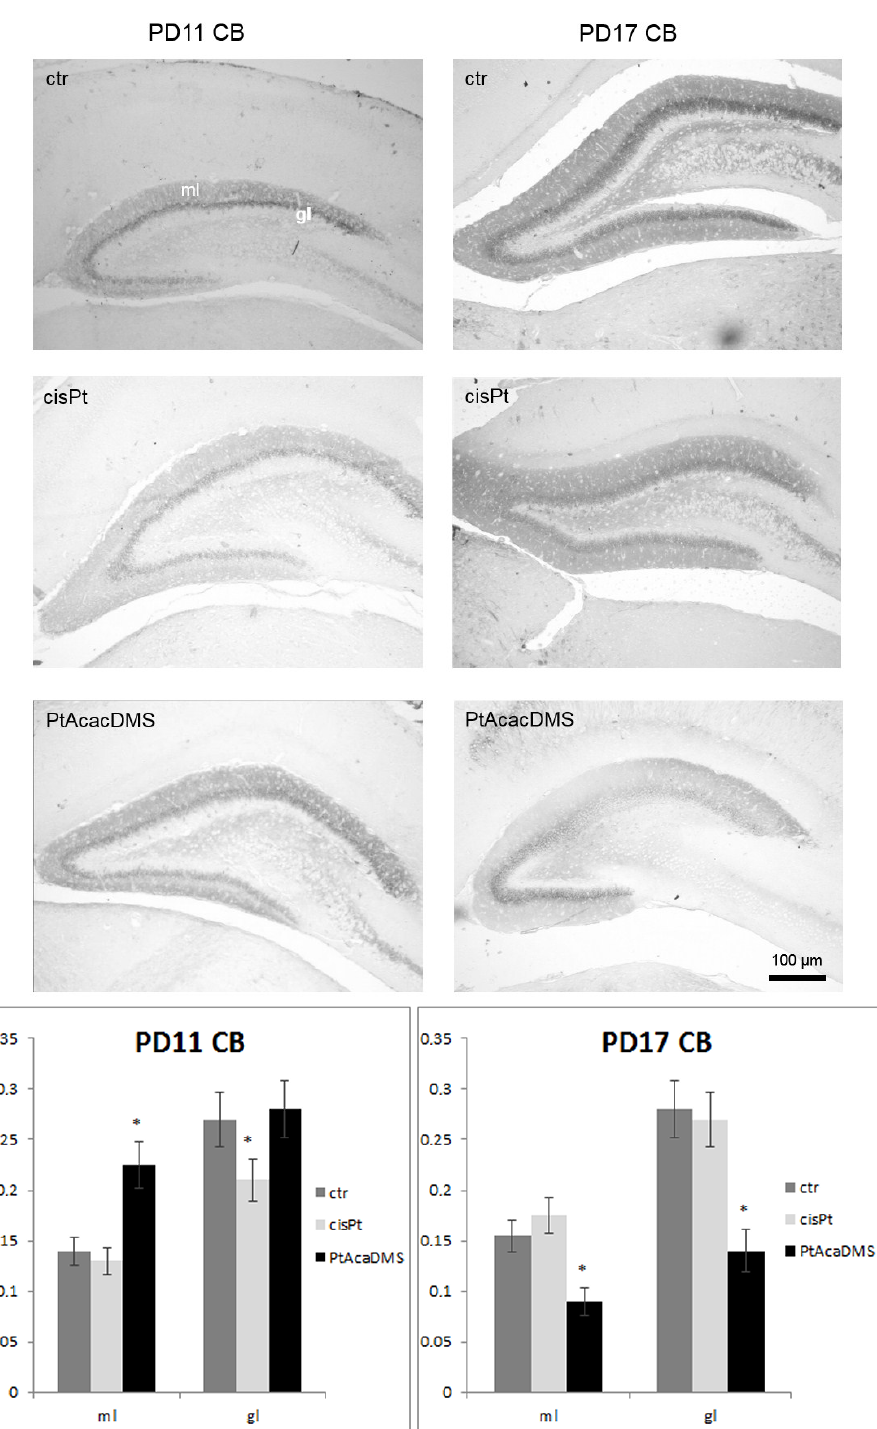
Figure 2. Calbindin immunocytochemistry in the DG granule cell layer . At PD11 , the intensity of labelling in the DG granule cells decreases after cisPt and increases after PtAcacDMS. At PD17 , decreased immunolabelling intensity is found after PtAcacDMS and not after cisPt. Histograms show the OD values and the significance of differences is reported (* p < 0.05). ml: Molecular layer; gl: Granule cell layer. Scale bar: 100